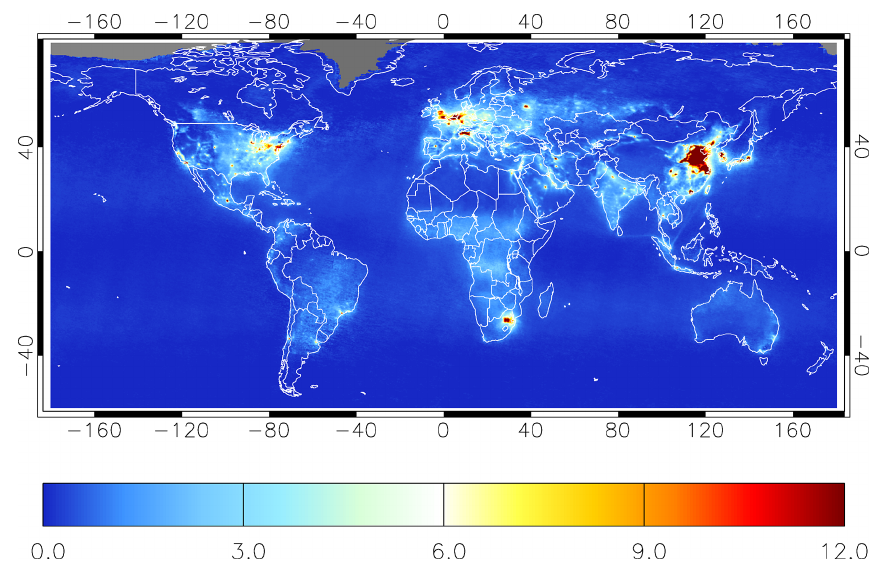
Figure 2. Tropospheric NO 2 VCD (in 10 15 moleculescm − 2 ) patterns as seen using the self-consistent GOME, SCIAMACHY, and GOME-2 dataset for the combined period April 1996–September